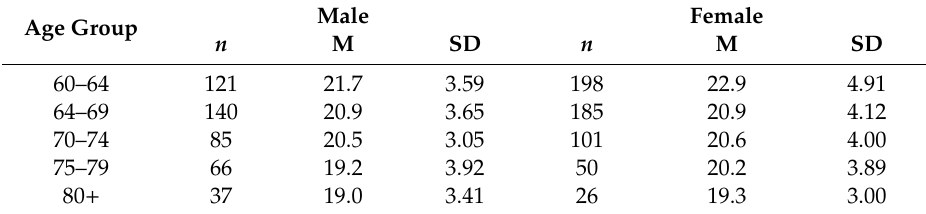
Table 4. Body mass index (BMI) based on age group and gender before log transformation, Unit: kg / m 2 .